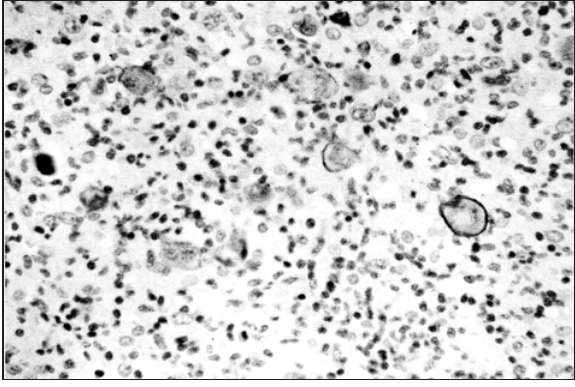
Figura 4 – Linfoma anaplásico de grandes células: imunopositividade de membrana celular com o anticorpo